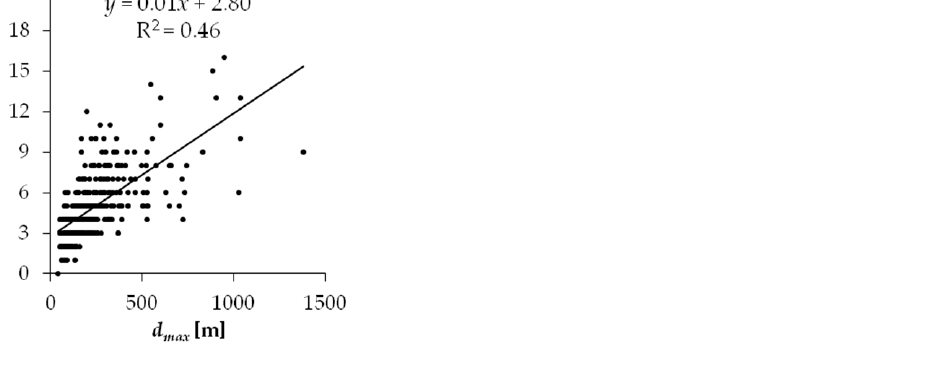
Figure 10. Relationship between maximum diameter ( d max ) and height ( H C 1 ) estimated from CartoSat-1 DSM, for the whole sample of tells mapped within the test area.